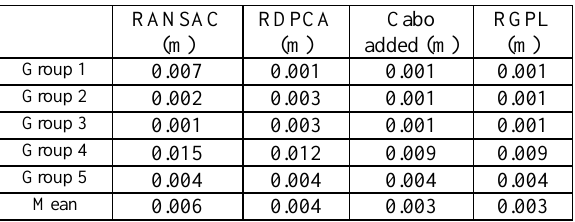
Table 12 RMSs after registration of four different